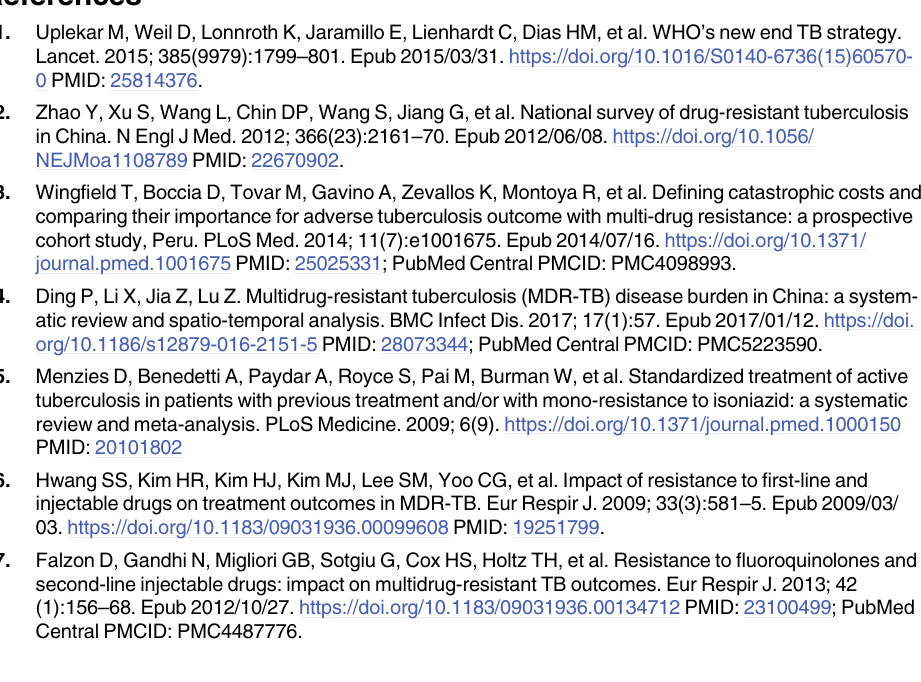
S4 Table. Univariate logistic analysis of high-frequency mutation sites and treatment out-